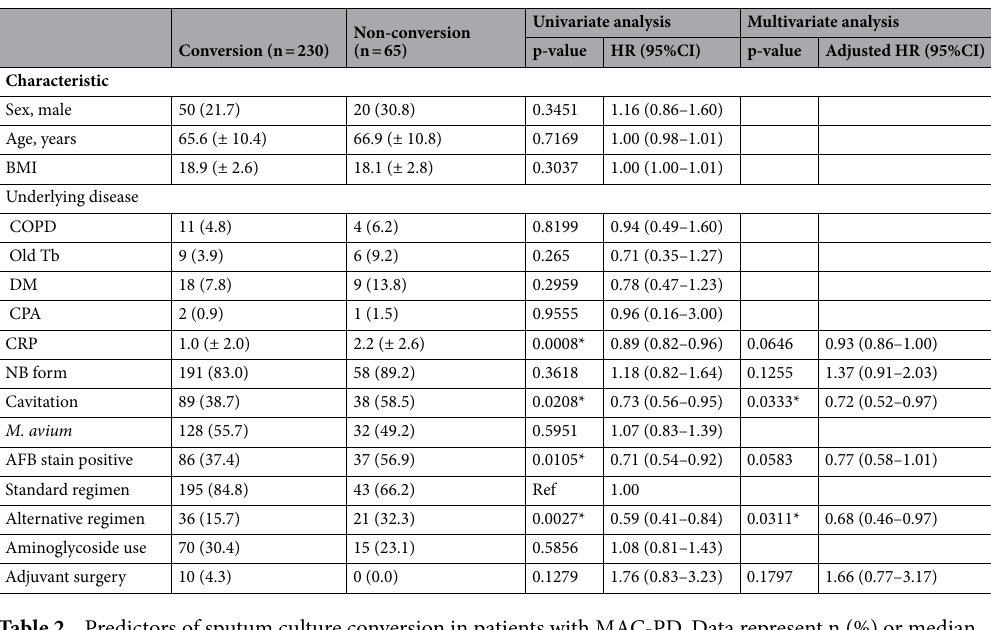
Table 2. Predictors of sputum culture conversion in patients with MAC-PD. Data represent n (%) or median (interquartile range). MAC-PD Mycobacterium avium complex pulmonary disease; HR hazard ratio; CI confidence interval; BMI body mass index; COPD chronic obstructive pulmonary disease; Tb tuberculosis; DM diabetes mellitus; CRP C-reactive protein; CPA chronic pulmonary aspergillosis; NB nodular bronchiectasis; AFB acid-fast